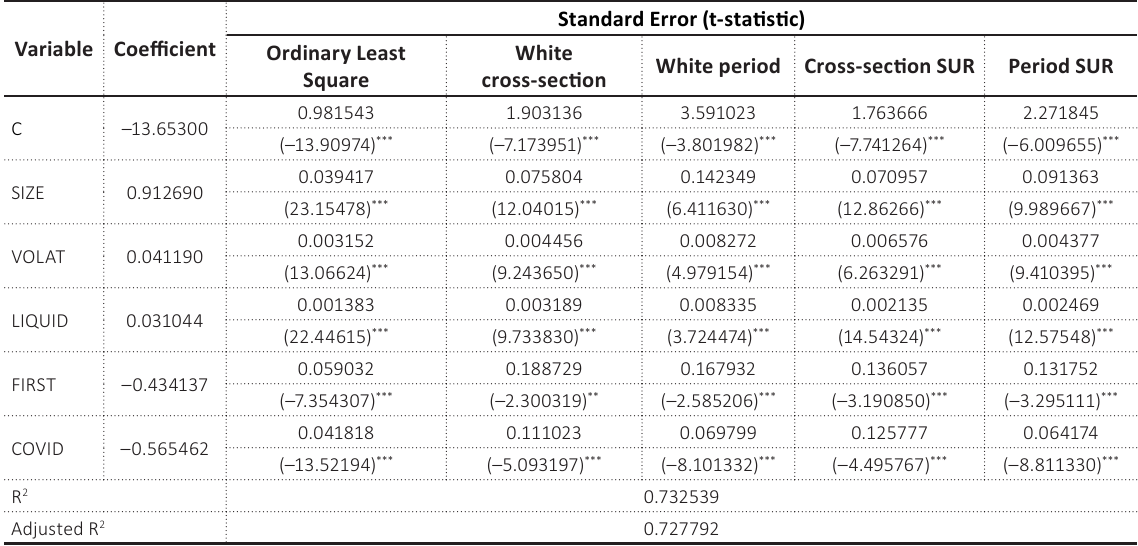
Table 7. Comparison of standard error estimates for FE